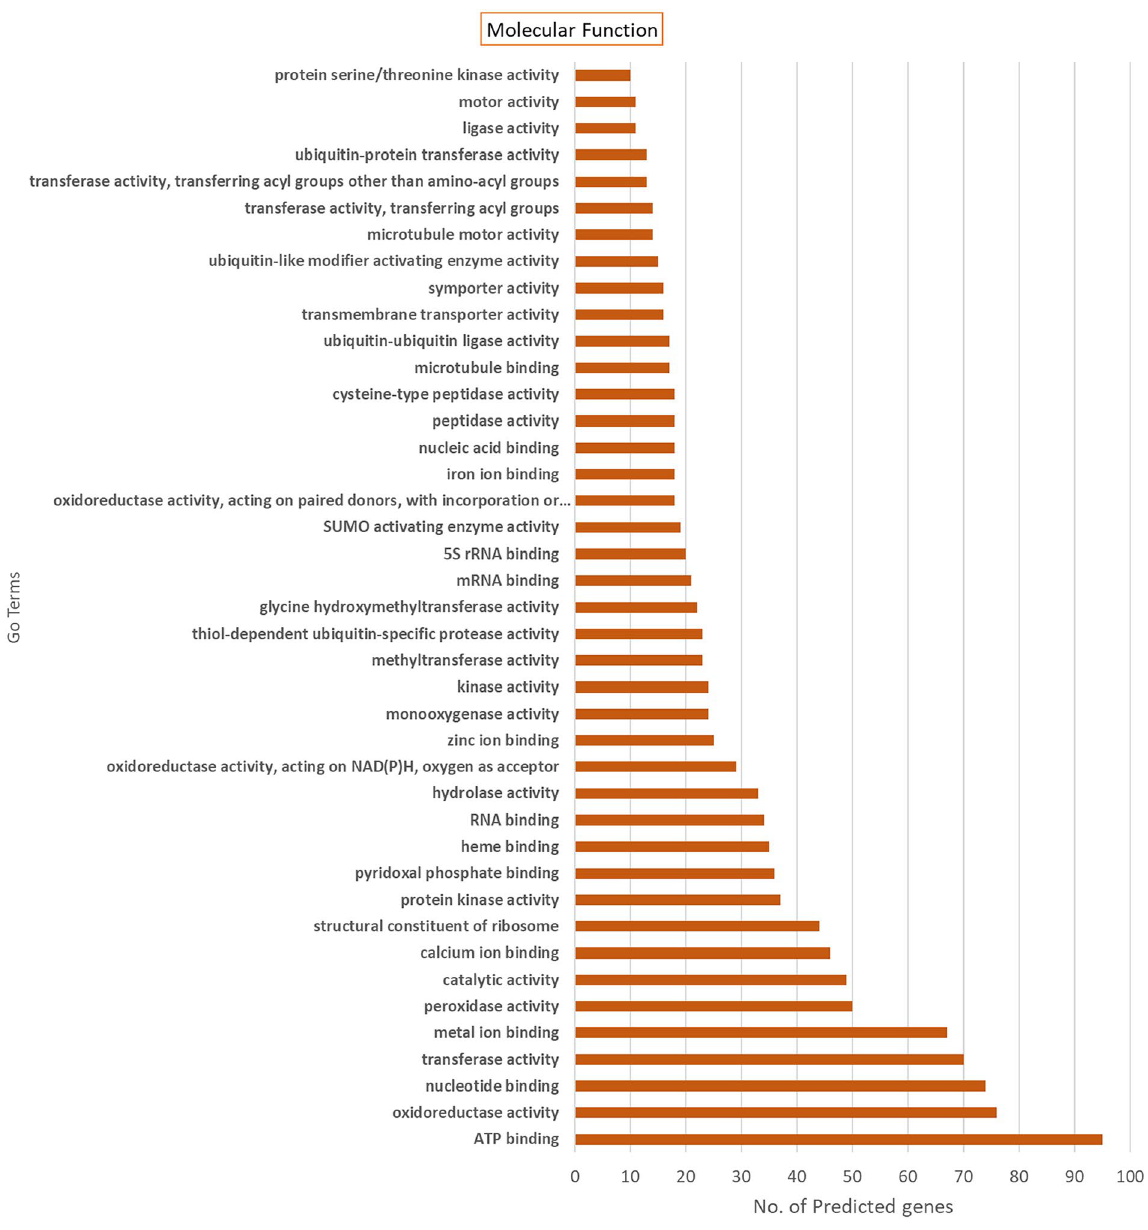
Figure 6. GO annotations distribution for the 128 SuperTranscripts assigned by Blast2GO 28 showing the associations to the Molecular Function domain for GO terms. It seems that a majority of the SuperTranscripts are associated with ATP binding activity as shown by the assigned GO